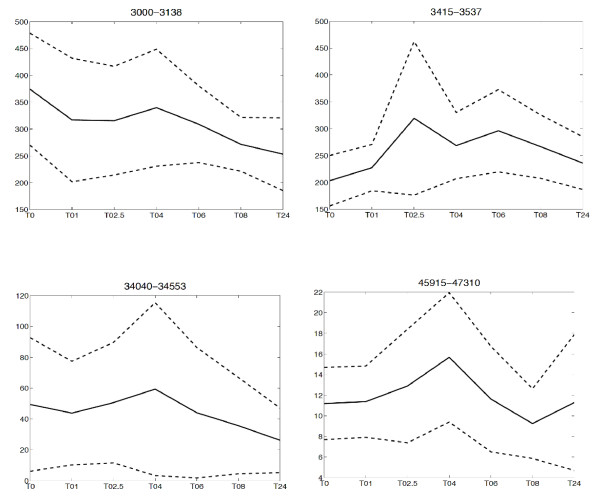
Plots representing the dynamics of the intensities of the intervals of interest averaged over all individuals. The dashed lines indicate plus/minus one standard deviation. In the x-axis the time course is indicated whereas the y-axis represents the total mean peak area.